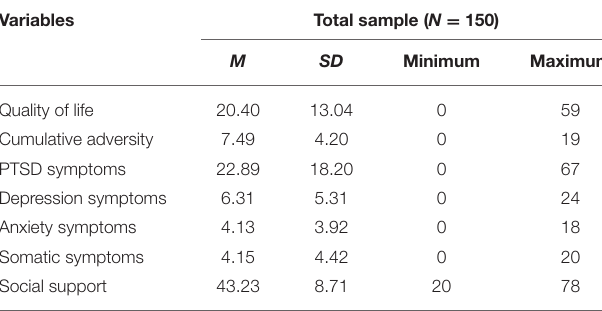
TABLE 1 | Means and standard deviation of key